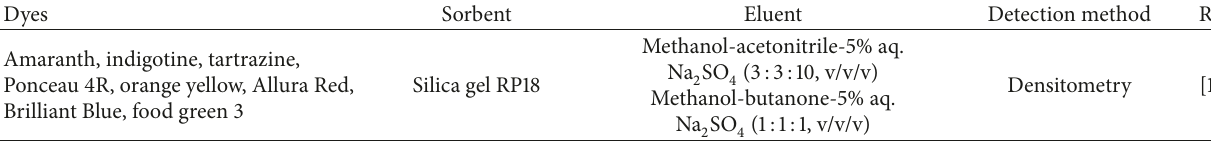
Table 1: Selected references on TLC separation and/or quantification of synthetic food dyes (including some illegal or delisted examples). Dyes Amaranth, indigotine, tartrazine, Ponceau 4R, orange yellow, Allura Red, Brilliant Blue, food green